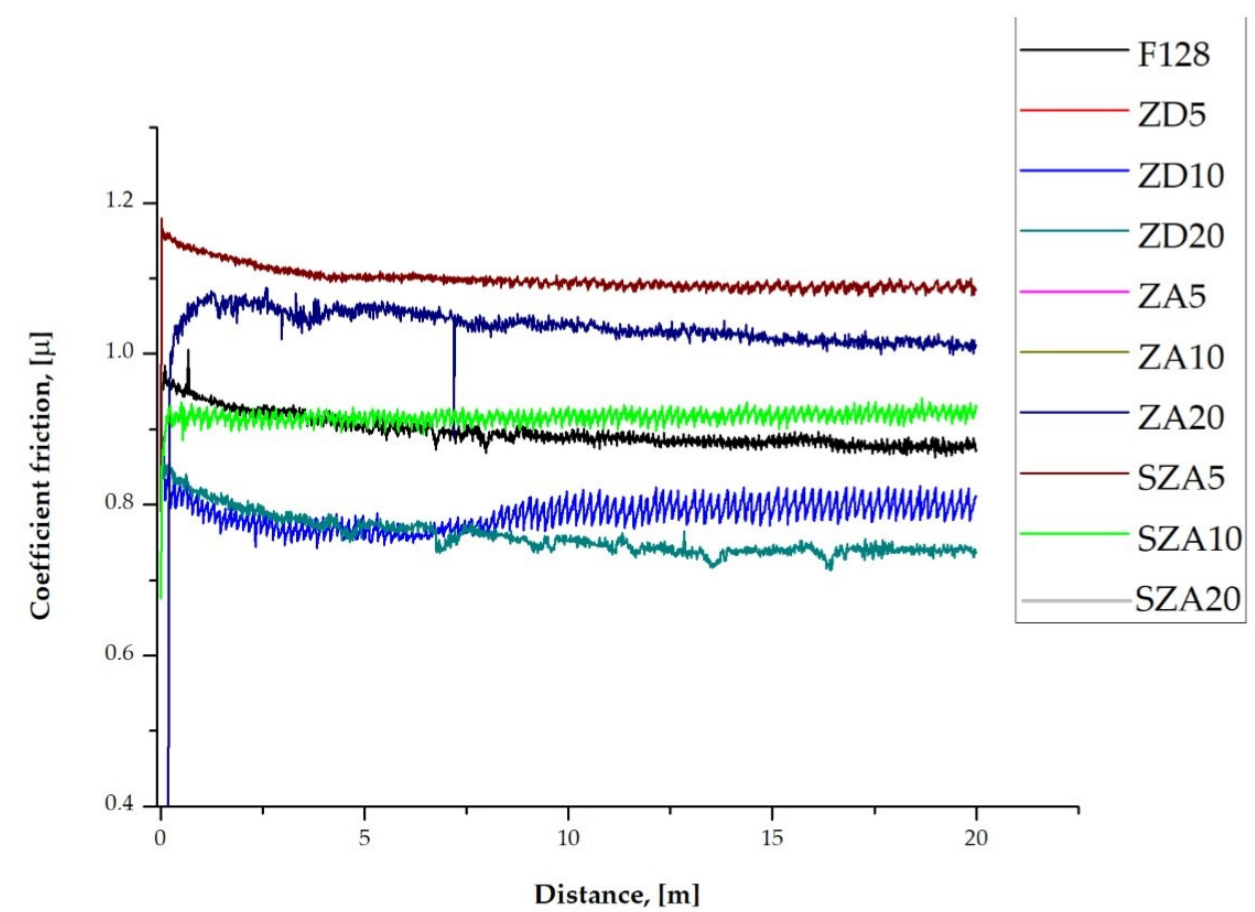
Figure 9. Coefficient friction of the tested materials. Table 7. Coefficient friction of the tested materials.